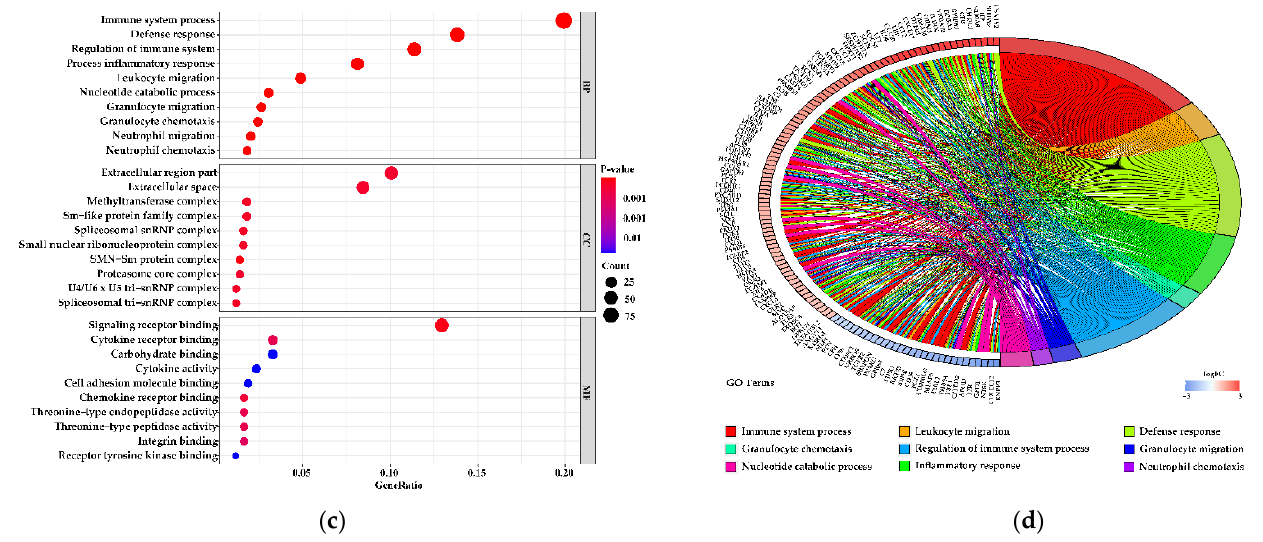
Figure 4. Gene ontology (GO) functional enrichment analysis of differentially expressed genes (DEGs). ( a , c ) Figures, respectively, show the top 10 significant GO terms for each category from ( a ) the 90 vs. 180 d group and ( c ) the 90 d vs. 270 d group. ( b , d ) Circos plots showing overlapping and specific responses of DEGs enriched in the nine most significant GO terms.